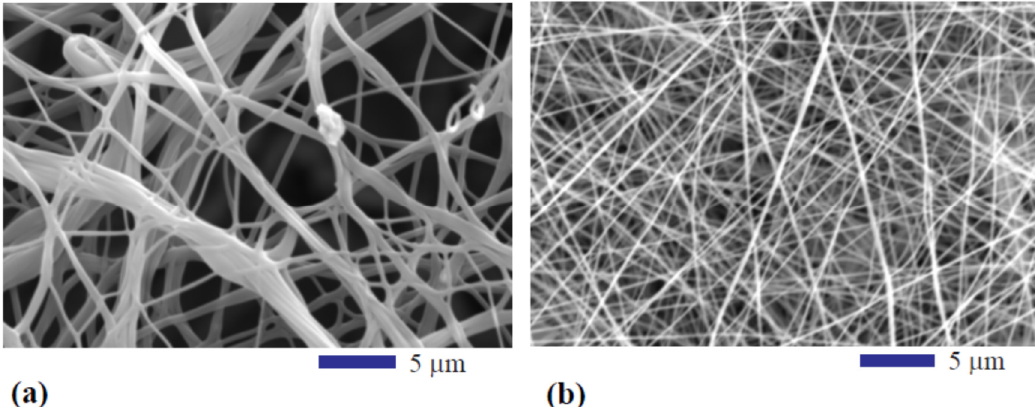
Figure 9. High magnification SEM images of: ( a ) the PAN-PMMA polymer blend fiber oxidized and stabilized at 250 °C; ( b ) the PAN fiber oxidized and stabilized at 250 °C.